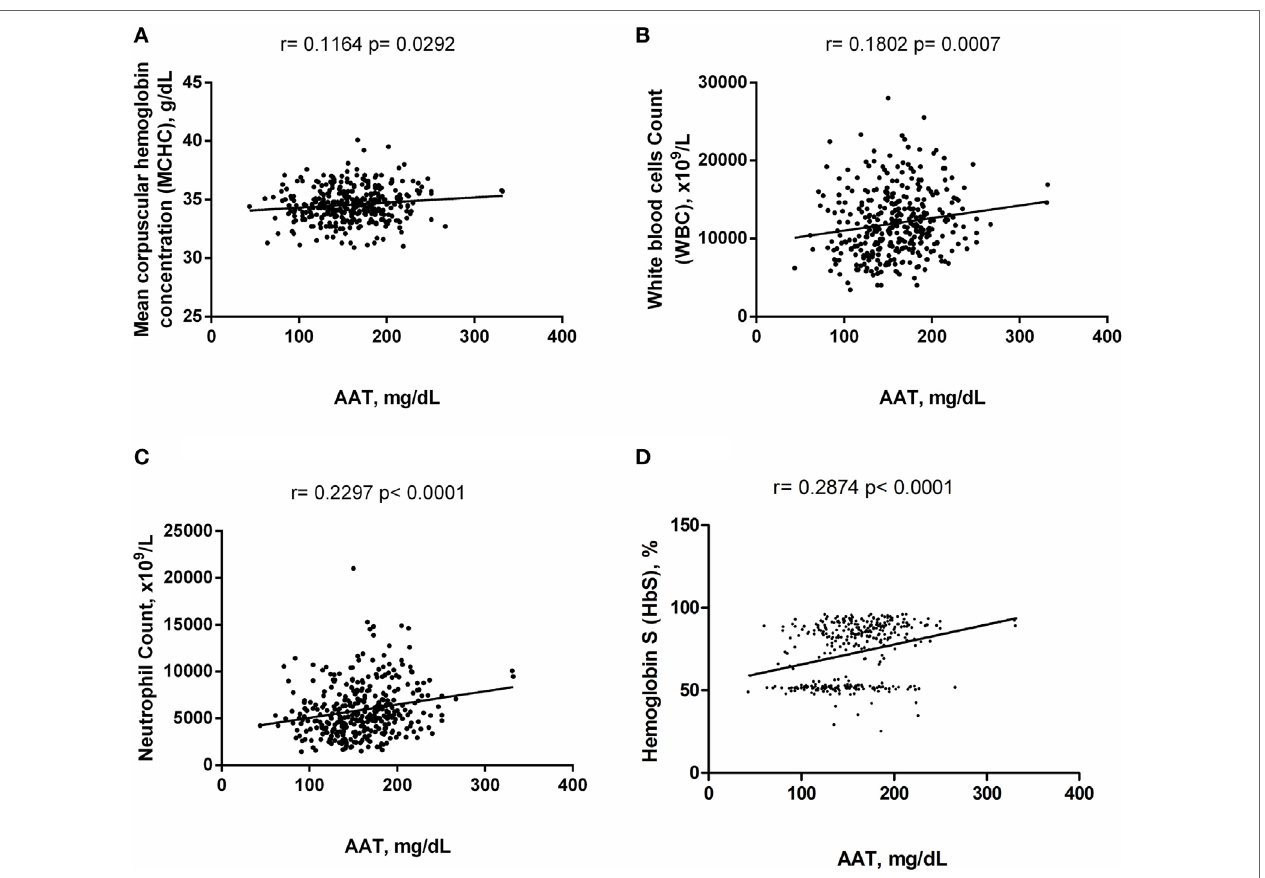
FigUre 3 | Positive correlations of alpha-1 antitrypsin (AAT) with hematological markers in steady-state sickle cell disease patients. (a) Mean corpuscular hemoglobin concentration; (b) white blood cell (WBC) counts; (c) neutrophil counts; (D) hemoglobin S